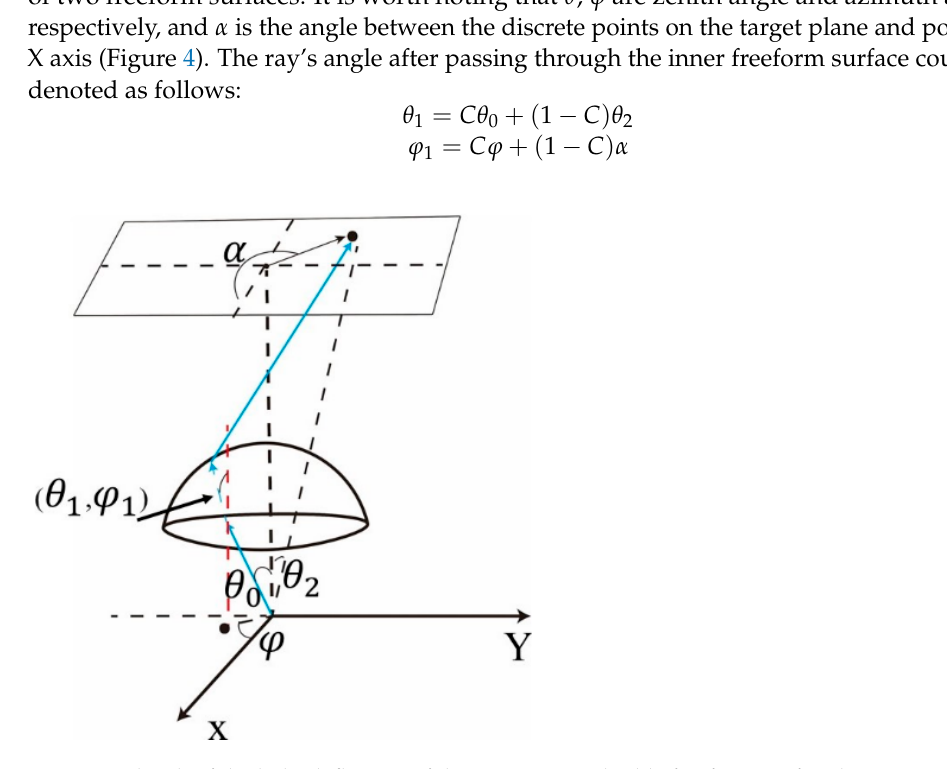
Figure 4. Sketch of the light deflection of the asymmetric double freeform surface lens.